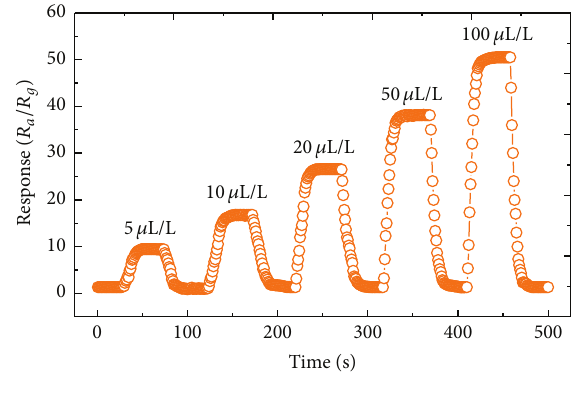
Figure 9: Dynamic C 2 H 2 sensing transients of the Sm 2 O 3 decorated SnO 2 nanorods sensor at 260 ∘ C.